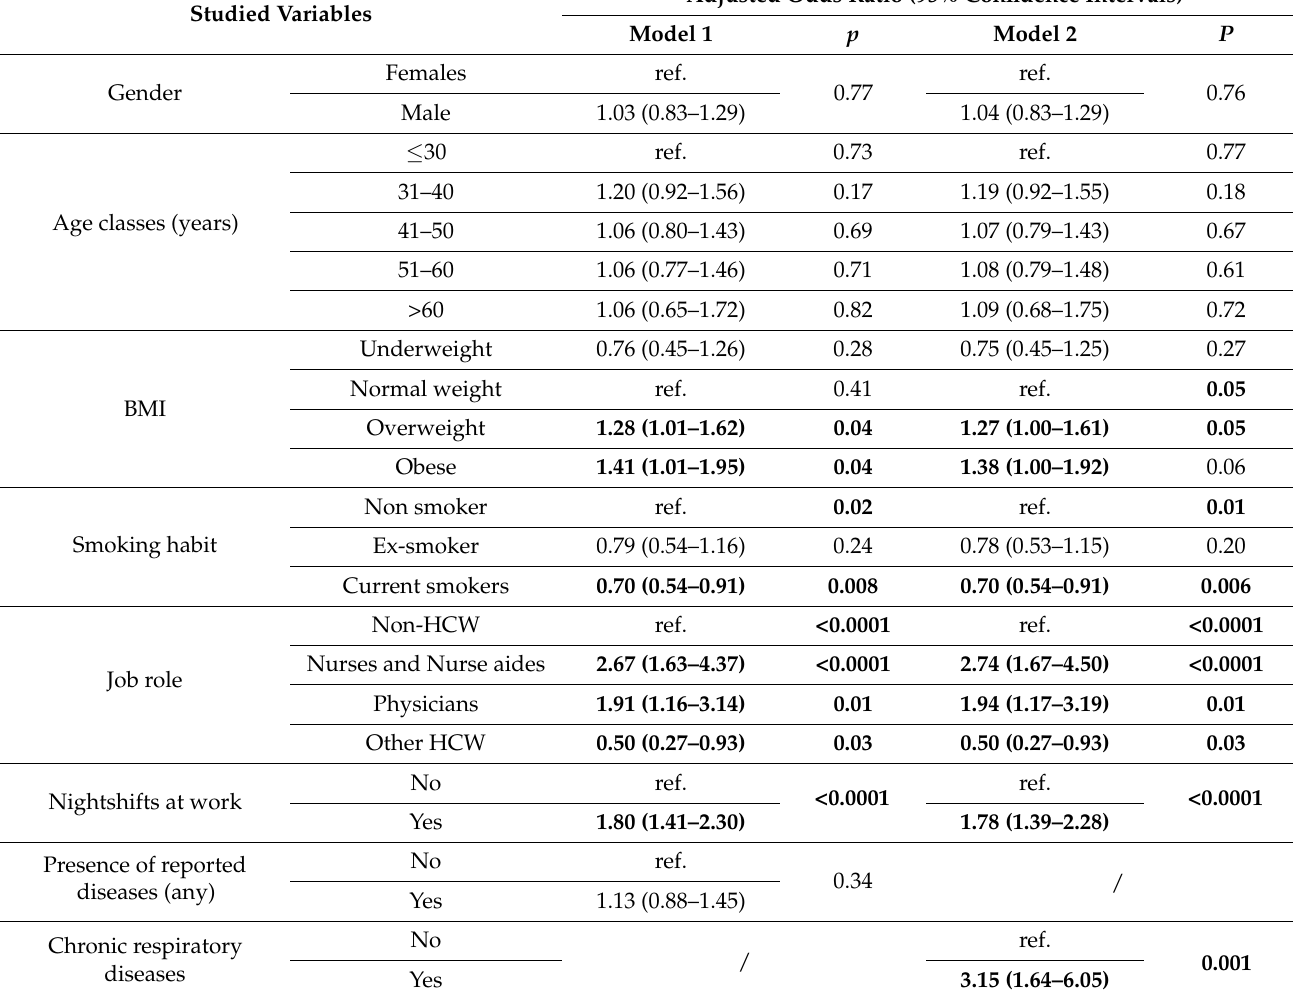
Table 2. Results of the multiple logistic regression analysis to evaluate adjusted odds ratios (aORs) with 95% confidence intervals (CI) for the variables gender, age, body mass index (BMI), smoking habit, job task, nightshift at work and the presence of any disease ( model 1 ) or the presence of chronic respiratory diseases ( model 2 ) in relation to the likelihood of being diagnosed with SARS-CoV-2 infection in the sample of workers of the University Hospital (significant results are marked in